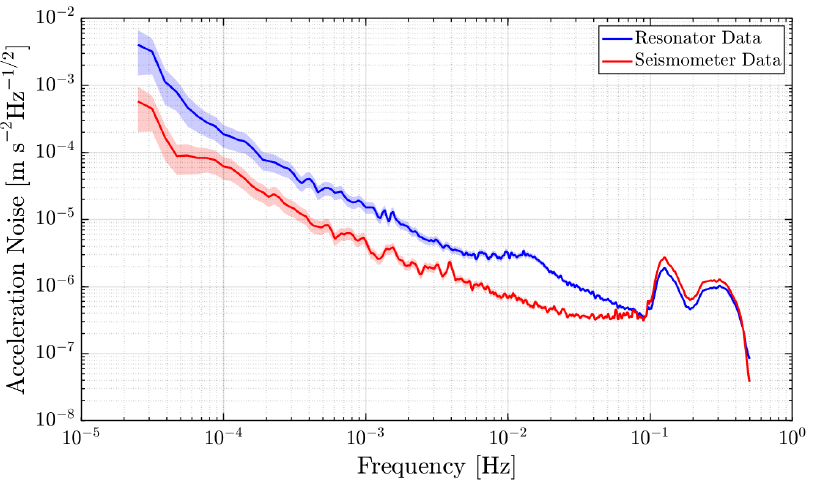
Figure 8. The acceleration noises measured by our optomechanical accelerometer and Trillium Horizon 120 seismometer. We observe good agreement between 100mHz and 500mHz. The shaded areas represent the estimated error bars of the